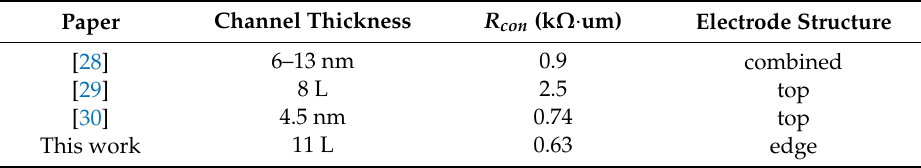
Table 3. R con comparison of di ff erent electrode